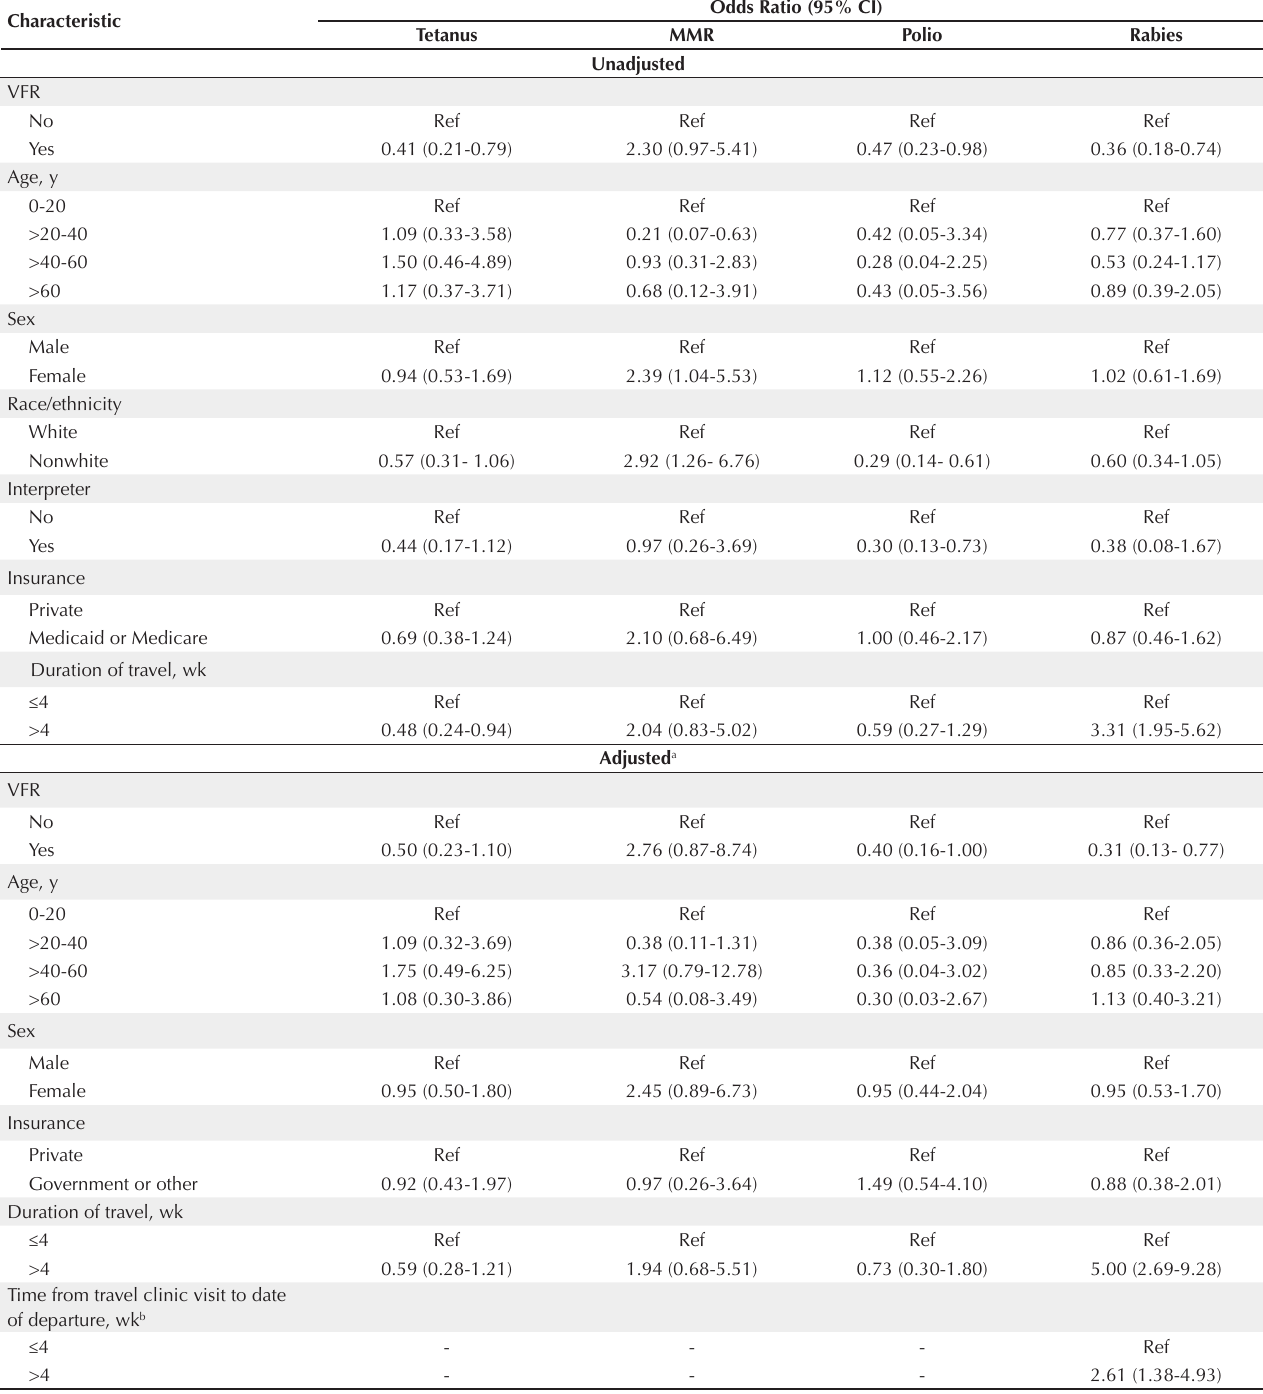
Table 3. Associations Between Patient Characteristics and Completion of Specific Recommended Vaccinations